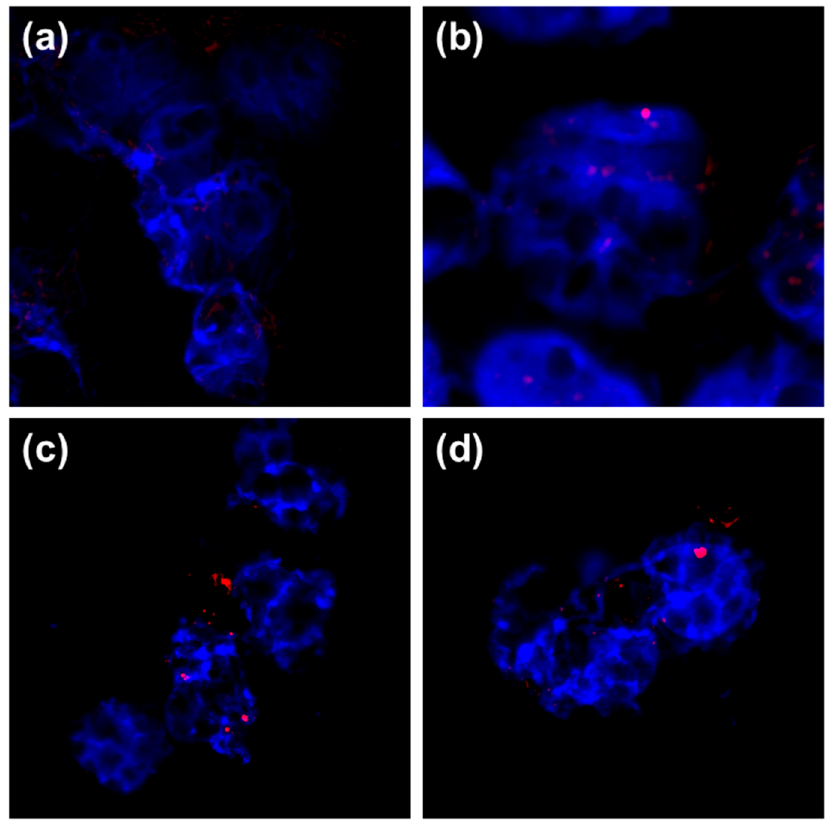
Figure 5. Visualization of AgNPs uptake by hPMBC performed by contrast reflection mode of CLSM. Untreated control cells ( a ) were compared to cells treated with AOT-AgNP ( b ), PVP-AgNPs ( c ) and PLL-AgNPs ( d ) for 3 h and at concentration of 1 mg Ag / L. The images show maximum intensity Z-projections of cells. Nucleic acid staining was performed using Hoechst 33,258 fluorescent dye (blue) to stain nuclei, while CLSM reflectance signals (red) are visible as bright red signals ( b – d ) indicating the presence of AgNPs.